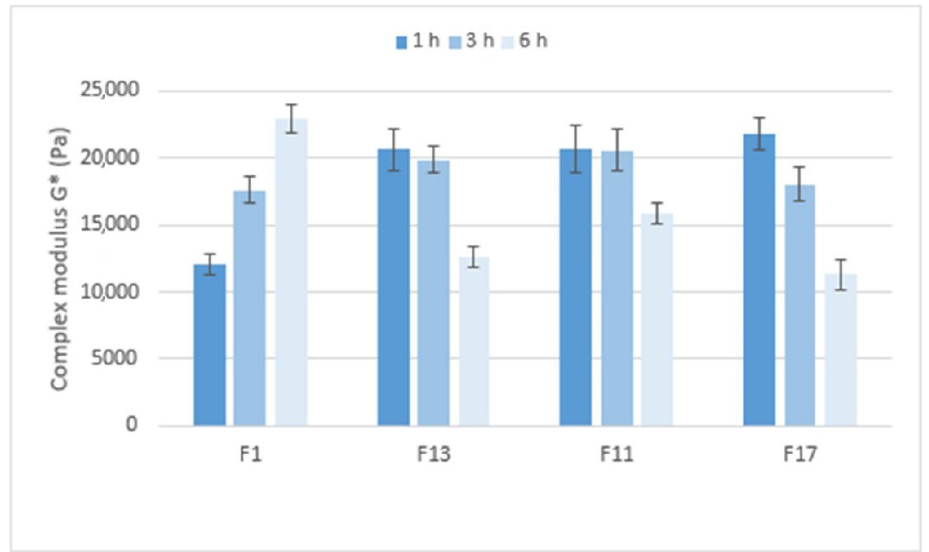
Figure 10. The values of the complex modulus G * (Pa) for matrix tablets F1, F11, F13 and F17.